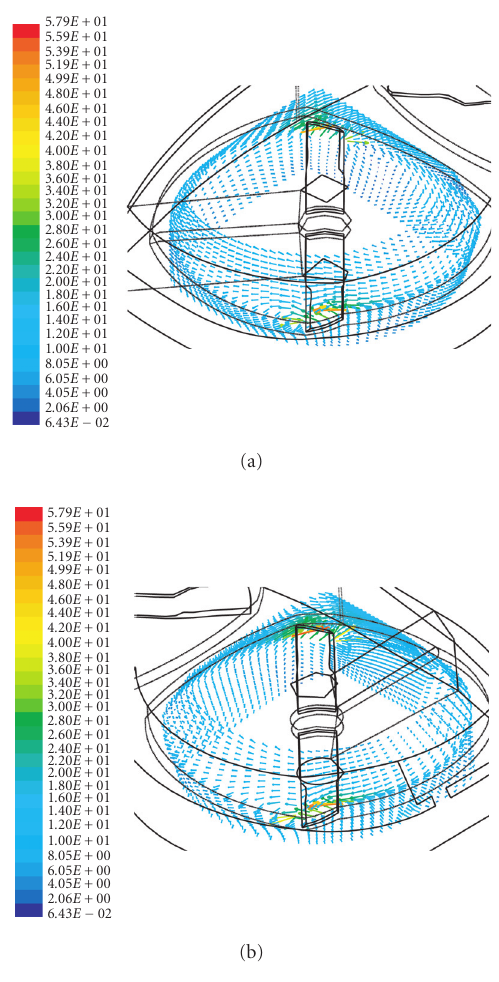
Figure 19: Velocity vectors at the radial planes (m/s): (a) at the plane of left side (b) at the plane of right